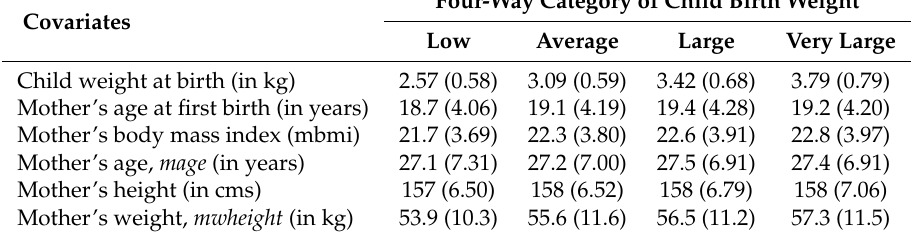
Table 4. Descriptive statistics of the continuous covariates used in the model by Four-way category of birth size in 2008 NDHS.